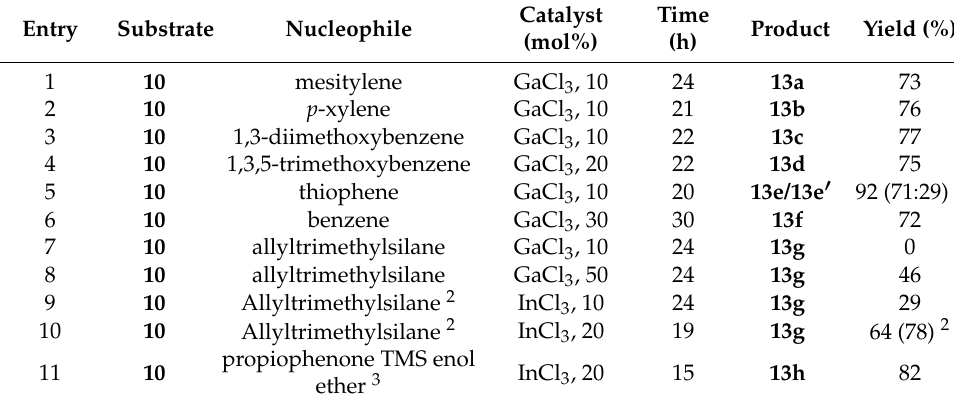
Table 4. Results for reactions of 10 .